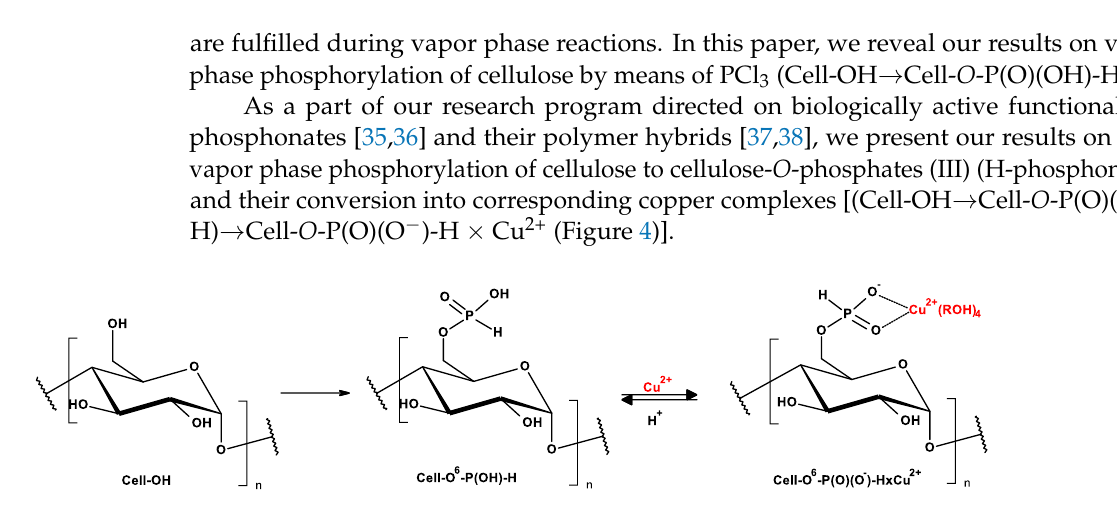
Figure 3. Gradual phosphorylation of cellulose (AGU m = AGU units deprived m(OH) ( m = 1 – 3) functions; ─ [AGU 1 (- O - P(O)(OH)-H)] n ─ , DS = 1; ─ [AGU 2 (- O -P(O)(OH)-H) 2 ] n ─ , DS = 2; ─ [AGU 3 -( O -P(O)(OH)-H) 3 ] n ─ , DS = 3).